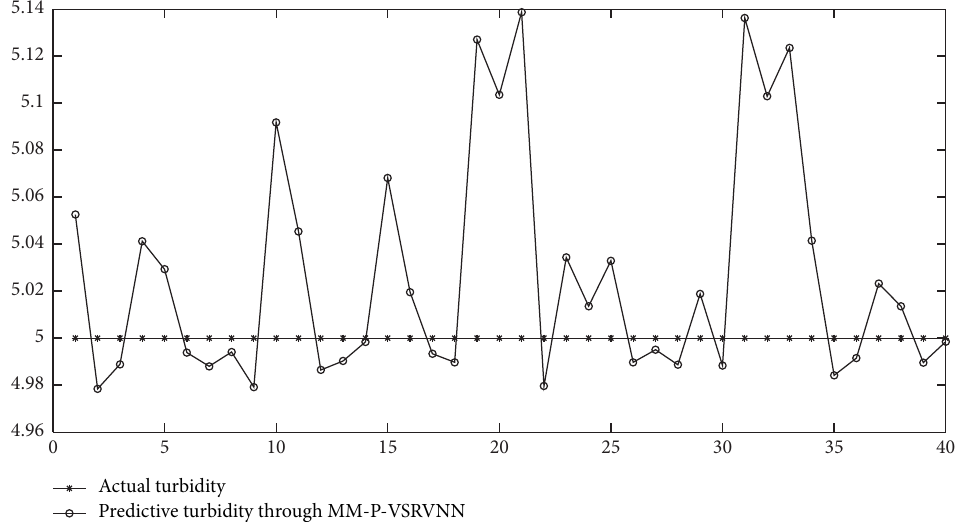
Figure 7: Prediction and actual value of turbidity before